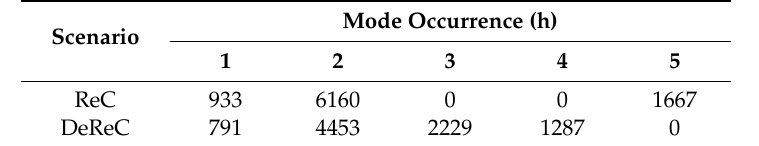
Table 4. Occurrence of control logic modes.